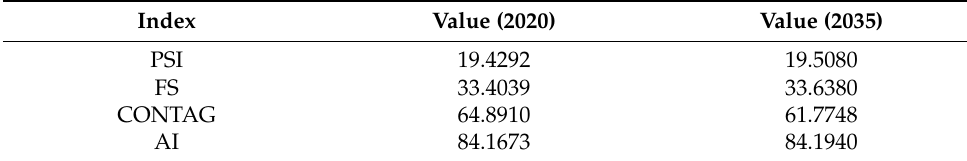
Table 3. The calculation result of PSI, CONTAG, FS and AI.